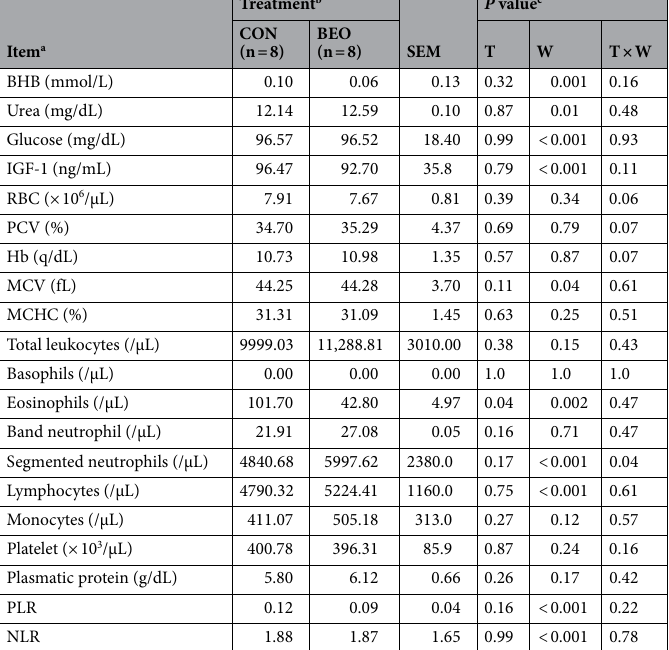
Table 3. Blood concentrations of metabolites, insulin growth factor type 1 (IGF-1), and hematological parameters of control bull calves (CON) and bull calves supplemented with a blend of essential oils blend (BEO) in milk replacer from 4 to 60 days of age. a RBC, red blood cell; PCV, packed cell volume; Hb, hemoglobin; MCV, mean corpuscular volume; MCHC, mean corpuscular hemoglobin concentration; PLR, platelet lymphocyte ratio; NLR, neutrophils lymphocytes ratio. b CON = control; BEO = 1 g/calf/day blend of essential oil. c T = treatment effect; W = week effect; T × W = treatment by week